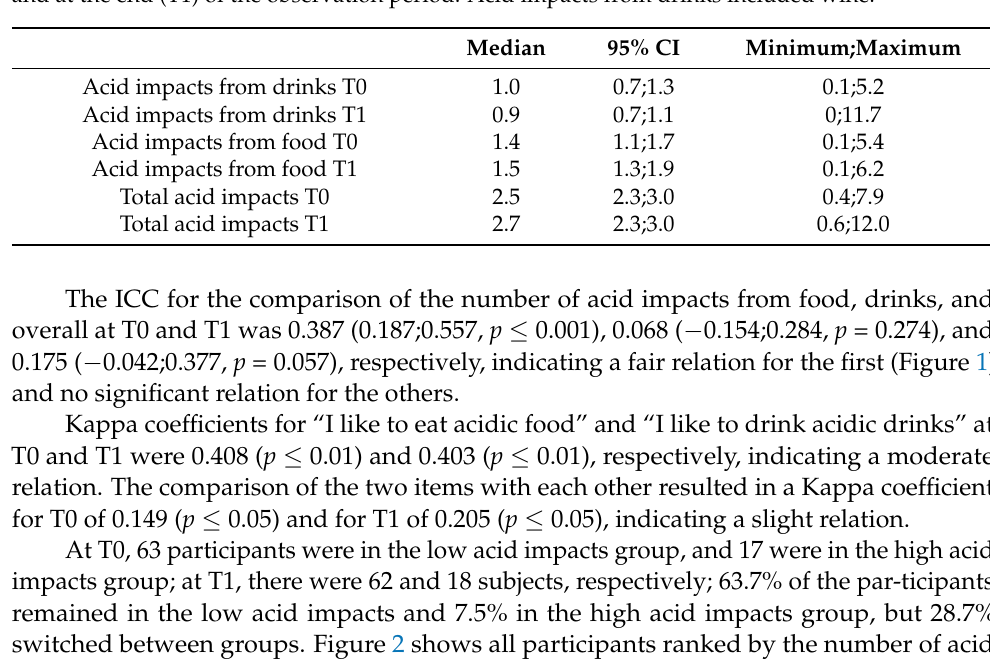
Table 1. Descriptive data of the number of acid impacts from different sources at the beginning (T0) and at the end (T1) of the observation period. Acid impacts from drinks included